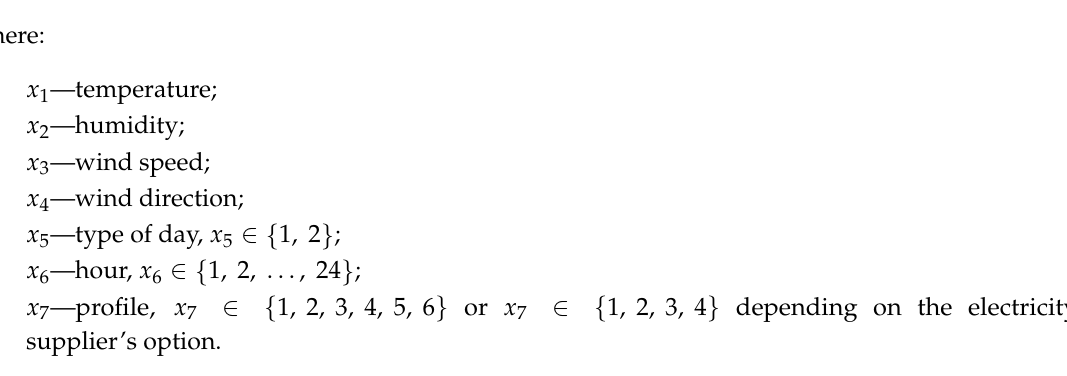
Figure 15. Load profiles obtained with 2 × 2 architecture.